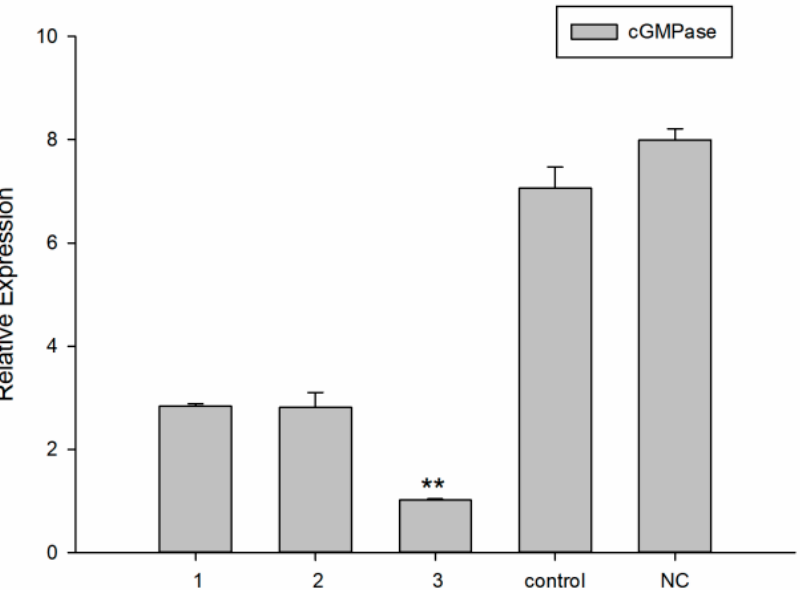
Figure 4. Screening for effective dsRNAs of cGMPase . Control was the blank group, and NC was the negative control group. Groups 1, 2, and 3 were the three chains. Double asterisks mean a highly significant difference (** p < 0.01).